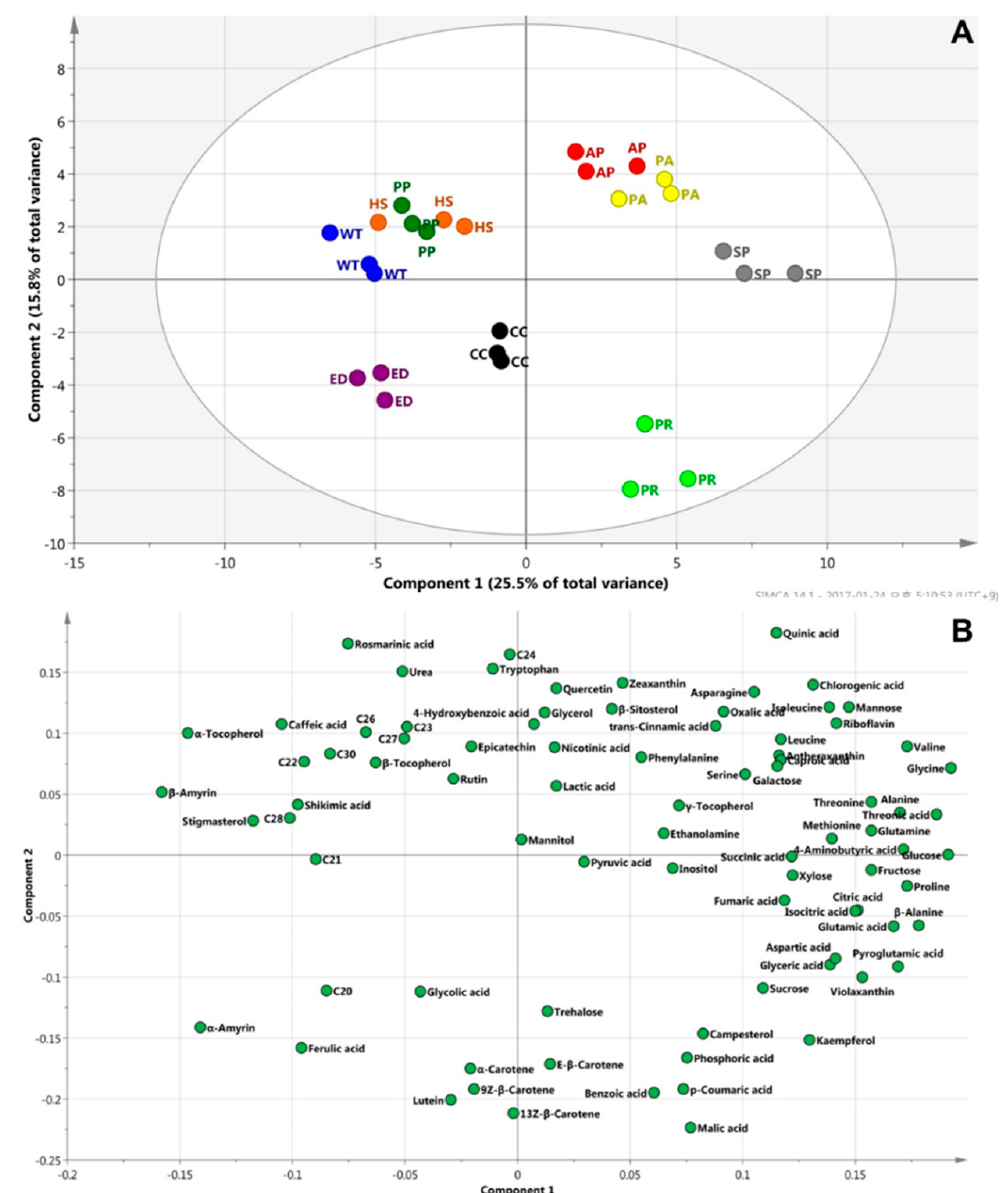
Figure 3. Principal component analysis (PCA) analysis of the metabolite profiles. ( A ) Score plot; ( B ) loading plot. AP, apple mint; CC, chocolate mint; ED, eau de cologne mint; HS, horse mint; PP,